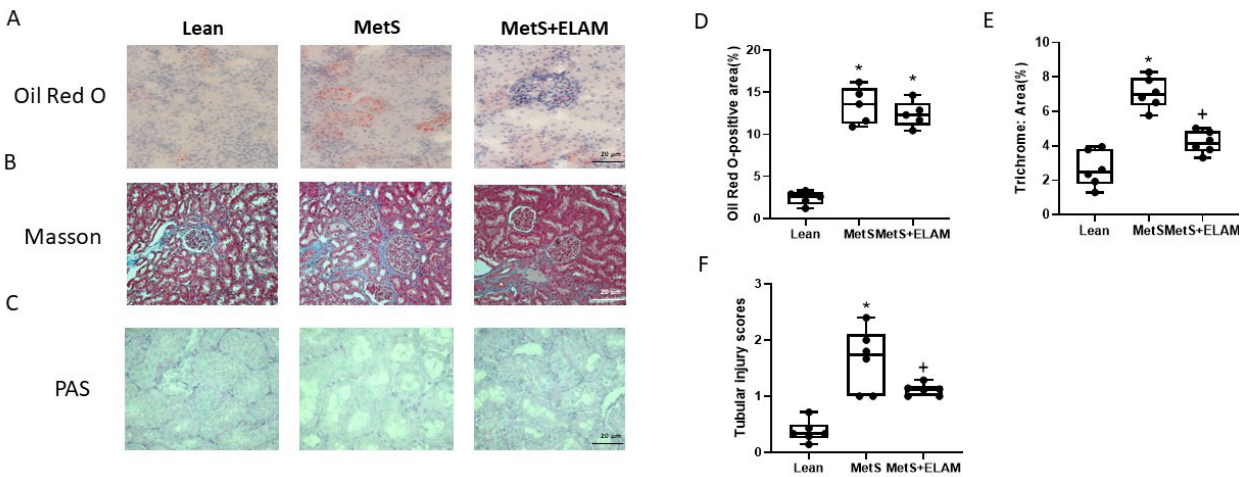
Figure 4. ELAM ameliorates renal damage in MetS. ( A , D ) Oil-red-O staining indicating kidney fat deposits in MetS, which were unaltered by ELAM; ( B , E ) Renal fibrosis (trichrome staining, blue) developed in MetS kidneys and decreased after ELAM. ( C , F ) Periodic acid-Schiff (PAS) stains showed increased renal tubular injury in MetS, which was reduced by ELAM. * p < 0.05 vs. lean, + p < 0.05 vs. MetS, Scale bar = 20 µ